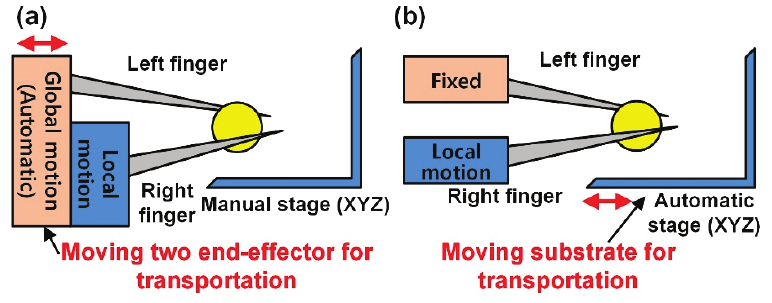
Figure 4. Transportation system. ( a ) Moving two end effectors; ( b ) Moving substrate.